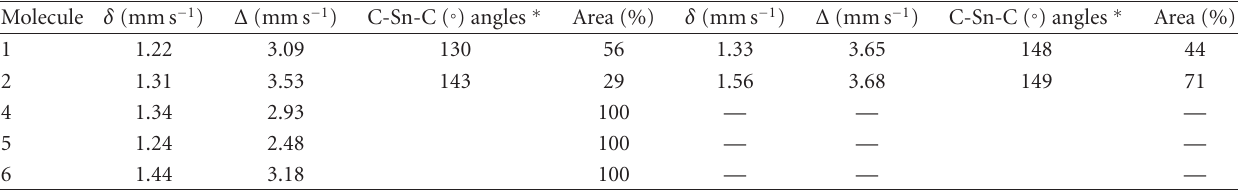
Table 2: 119 Sn M¨ossbauer spectroscopic data for complexes 1 – 6 at 80